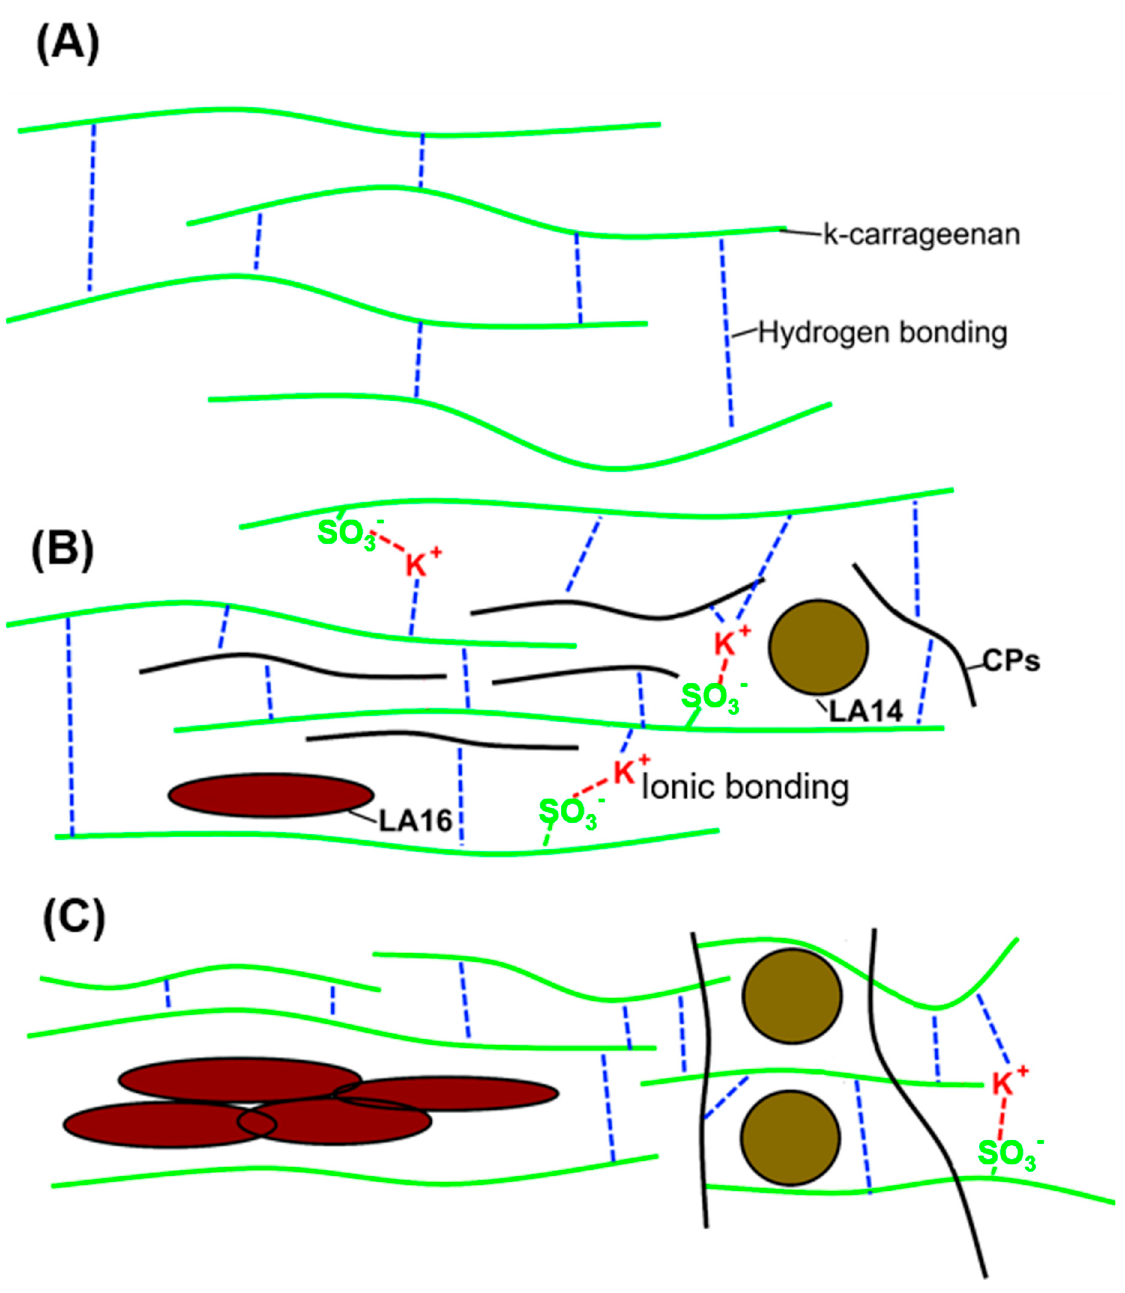
Figure 11. Schematic illustration of a proposed gel network in 3% k ‐ carrageenan ( A ), 3% k ‐ carrageenan enriched with LA callus at 33 g/100 mL ( B ), and 3% k ‐ carrageenan enriched with LA callus at 66 g/100 mL ( C ) inks. CPs–callus polysaccharides. LA14 and LA16–LA14 and LA16 callus cells, respectively. Ionic and hydrogen bonds are shown as red and blue dotted lines, respectively. The polysaccharide chain of k ‐ carrageenan is shown as a solid green line.